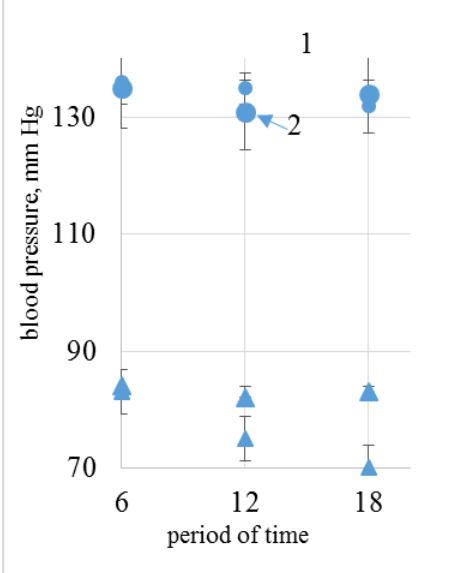
Fig. 6. Fluctuations in systolic (●) and dystolic ( ▲ ) blood pressure in summer (1) and winter (2) Table 3. Estimated average values of the indicators of the functional state of drivers at the beginning and at the end of the change